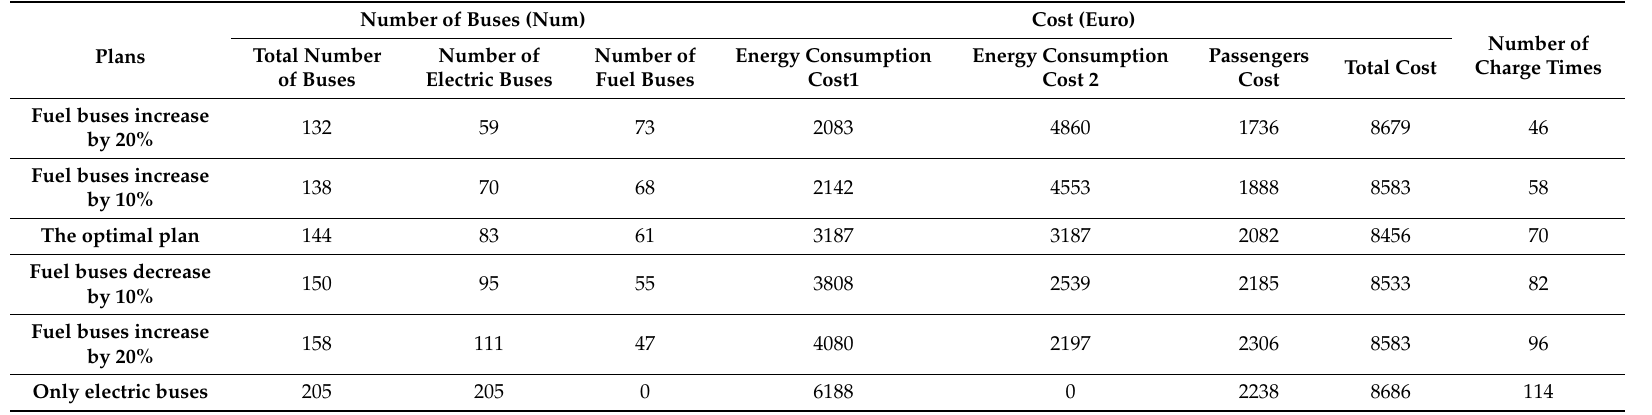
Table 7. The cost of di ff erent vehicle type